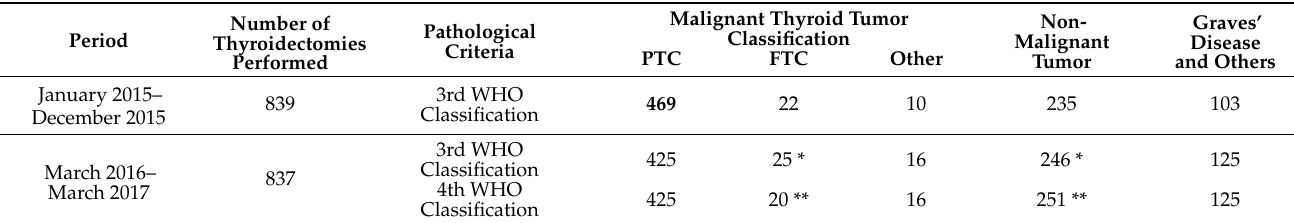
Table 1. Numbers of thyroidectomies performed and the frequencies of pathological diagnoses in the periods indicated.